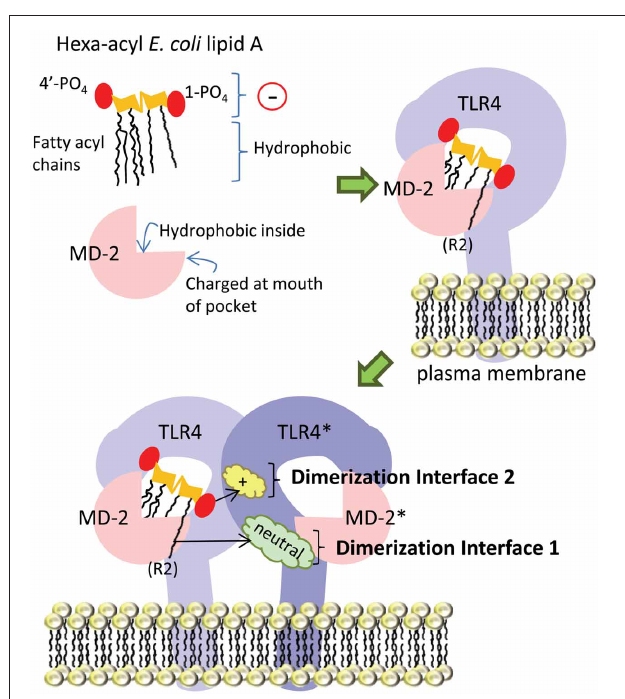
FIGURE 4 | Simplified diagram of TLR4-MD-2 receptor complex dimerization upon ligation of hexa-acyl lipid A. The amphipathic lipid A molecule consists of negatively-charged (indicated by a circle with a “ − ” sign in it) phosphate groups and hydrophobicfatty acyl chains. The fatty acyl chains sit inside the “binding pocket” structure of the MD-2 co-receptor protein, which is lined with hydrophobicamino acid residues, while the phosphate groups are engaged by charged amino acids in MD-2 at the mouth of the pocket. In the next part of the figure, we show lipid A inside the MD-2 pocket and also in contact with TLR4, with which it forms a 1:1 complex. Upon lipid A binding, this TLR4-MD-2 complex dimerizes with a second complex. From this position, lipid A engages the TLR4 molecule in the second complex (TLR4 ∗ ) at two main interfaces: the first is mediated by interaction of the 6th acyl chain of lipid A (which is shown sticking out of the pocket) with uncharged amino acids (cloud labeled “neutral”) on TLR4 ∗ , the second is mediated by interaction of the negatively-charged 1-phosphate (1-PO 4 ) on lipid A with positively-charged amino acid residues (cloud labeled “ + ”) on TLR4 ∗